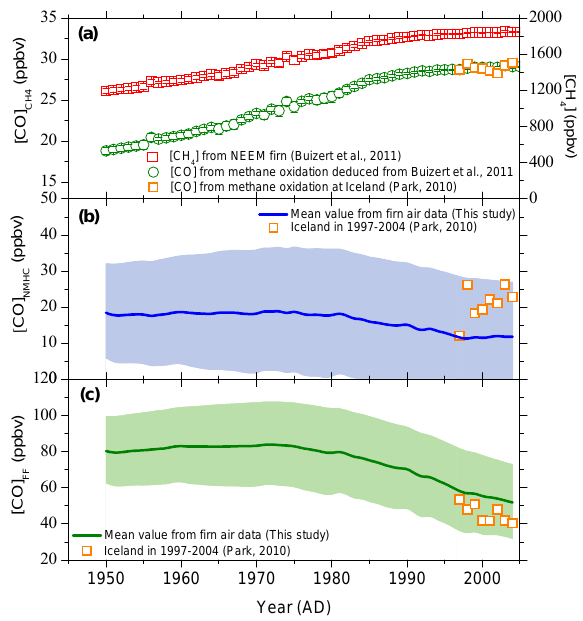
Fig. 6. Modeled CO source partitioning based on observations and isotope mass balance model: (a) : Methane atmospheric trend at high northern latitude (Buizert et al., 2011) (red squares) and [CO] ) deduced from the methane from methane oxidation ([CO] CH 4 concentration (green circles), (b) : [CO] from NMHC oxidation ([CO] NMHC ) , and (c) : [CO] from fossil fuel combustion ([CO] FF ) . Thick lines in (b) and (c) represent the mean values of different scenarios and shaded areas represent the uncertainties which arise from the LGGE-GIPSA models simulation uncertainties on both CO concentration and δ 18 O, as well as the uncertainties for estimat- ing historical CO emissions from biofuel and biomass burning (Ito and Penner, 2005). [CO] derived from the three major sources since 1950 is calculated based on an isotope mass balance model (Wang et al., 2010). CO source partitioning at present day is calculated based on MOZART-4 and inverse modeling and CO measurements in 1997–2004 at Iceland (orange squares) (Park, 2010).